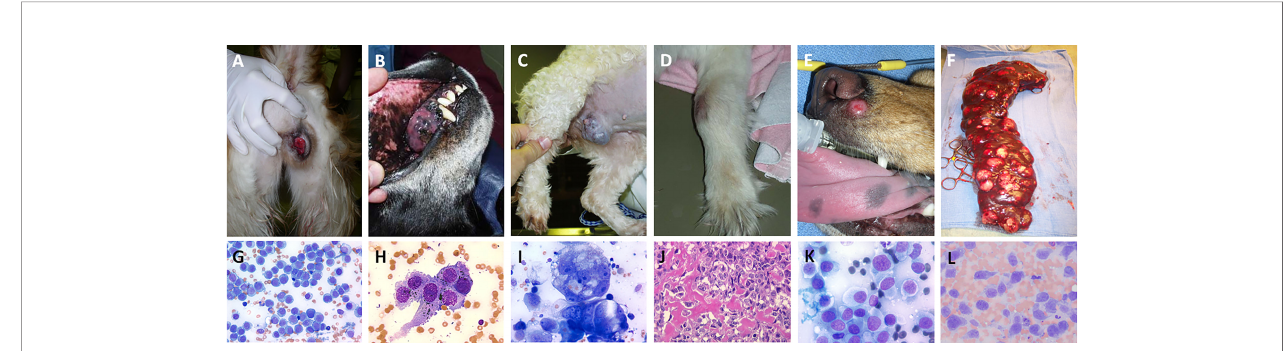
FIGURE 2 | Panel of spontaneously-arising tumors in pet dogs demonstrating classic clinical presentation and associated representative cytologic or histologic features. All tumors presented are considered immunogenic in nature and can be leveraged for evaluation of novel immunomodulatory strategies for cancer therapy and include (A, G) canine transmissible venereal tumors, (B, H) oral malignant melanoma, (C, I) mammary gland carcinoma, (D, J) appendicular osteosarcoma, (E, K) cutaneous histiocytoma, and (F, L) splenic histiocytic sarcoma. Cytology and histology images, magni fi cation